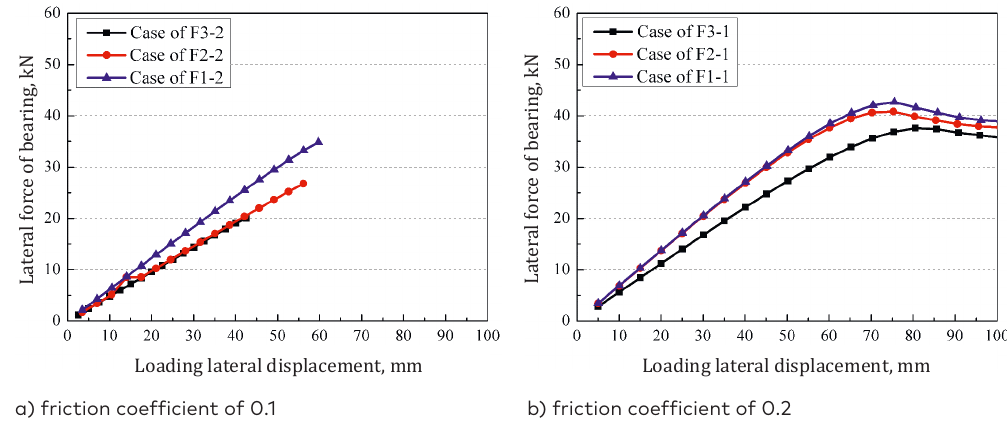
a) friction coefficient of 0.1 b) friction coefficient of Figure 8. Comparisons of horizontal force displacement curves under symmetry friction connection at both ends